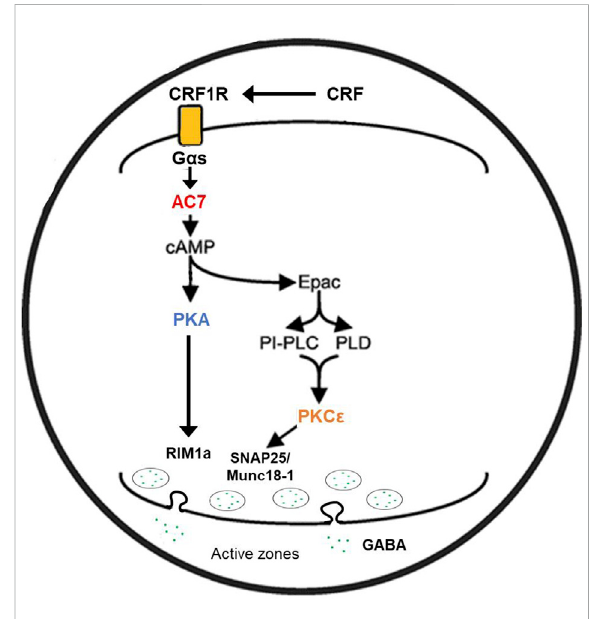
FIGURE 2 Proposed mechanism of ethanol potentiation of CRF- mediated GABA release in the central amygdala. In the pre- synaptic terminal CRF interacting with CRF1 receptors coupled to Gs protein acts to enhance the activity of AC7. Ethanol potentiates the G α s-mediated catalytic activity of AC7 and increases the generation of cAMP. cAMP can interact with two effector molecules, PKA and Epac (Hucho et al., 2005; Robichaux and Cheng, 2018; Wang et al., 2022a) to engage two distinct pathways (Gekel and Neher, 2008) modulating transmitter release (e.g., GABA). The exocytosis of the contents of vesicles requires fusion of the vesicle with the pre-synaptic membrane and positioning of the vesicle in proximity to N or P/Q-type Ca ++ channels (Südhof and Rizo, 2011). cAMP has also been shown to modulatevesicleloadingwithneurotransmitter(Costaetal.,2017). The fusion of vesicles with the synaptic membrane, pore formation, and transmitter release requires the interaction of several proteins including RIM proteins, Munc 13 – 1, Munc 18 – 1, and SNAP proteins. These proteins can be phosphorylated by PKA or PKC ε (Lonart et al., 2003; Sossin, 2007; Brockmann et al., 2020) and such phosphorylation modi fi es their function. The change in function of the transmitter release machinery can be measured by amplitude and frequency of post-synaptic mIPSPs or mEPSPs. Ethanol-inducedpotentiationofCRF-initiated GABAreleaseinthe central amygdala (Nie et al., 2009) was diminished by knockdown of AC7 or knockout ofPKC ε (see text), and thisillustration provides a rendition of the interactive pathways by which the observed effects can be